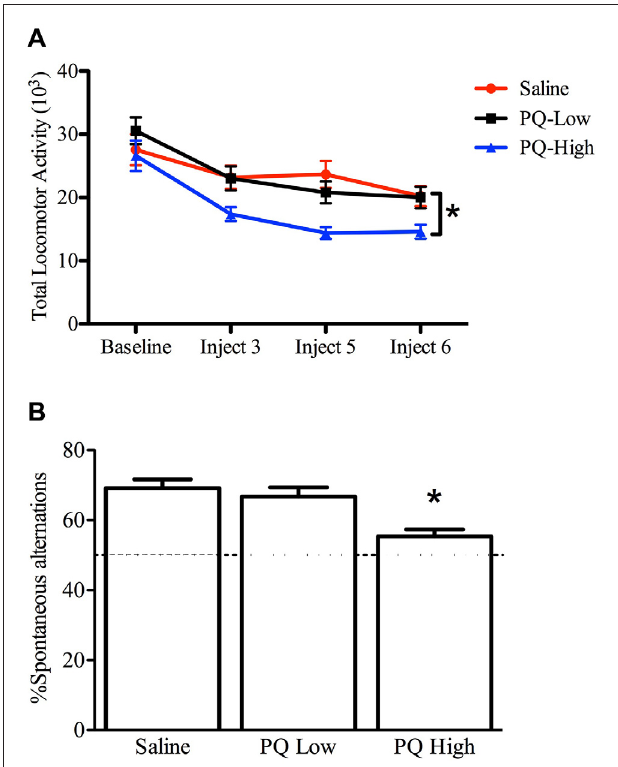
FIGURE 3 | Dose-dependent effects of short term paraquat treatment on home cage activity and Y-maze performance. As depicted in (A) , the higher dose of paraquat (PQ-High; 10 mg/kg; blue line) significantly reduced home cage activity, relative to mice treated with the low toxicant dose (PQ-Low; 1 mg/kg; black line) or saline (red line). As depicted in (B) , the high paraquat dose likewise reduced the number of spontaneous alternations in a Y-maze task, suggesting some degree of cognitive deficit. ∗ p < 0.05, relative to saline or low-dose paraquat treated mice.